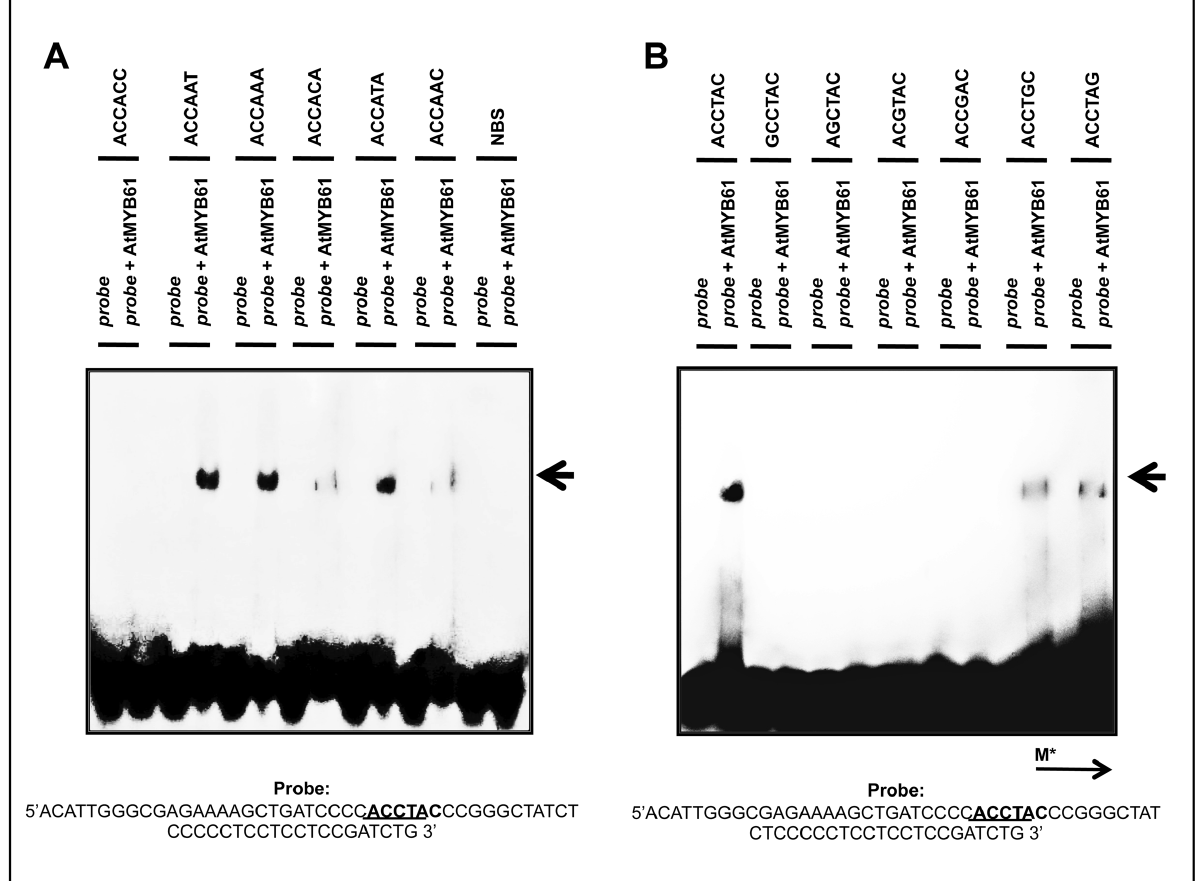
Figure 2. Relative binding affinities of AtMYB61 to CASTing targets and to mutated ACCTAC motif determined by nitrocellulose filter-binding assays are confirmed by electrophoretic mobility-shift assays (EMSAs). (A) EMSA of recombinant AtMYB61 protein binding to 6 labelled CASTing target sequences. The protein concentration used was 5 6 10–08M. Protein concentrations were conducted at 5 6 10–08M because this was the protein concentration at which targets had not all reached their binding max as determined by nitrocellulose filter-binding assay, allowing one to observe differential binding. (B) EMSA validating relative binding affinities of AtMYB61 to mutated ACCTAC motif. The protein concentration used was 5 6 10–08M. Mutations were conducted by substituting a single guanine nucleotide along the AC1 element. Black arrow indicates gel shift by the probe. Non-binding site (NBS) is a sequence that does not bind AtMYB61, acting as a negative control. Probes were engineered for the EMSA reaction by inserting the hexamer CASTing sequence or mutated AC1 element sequence into the underlined